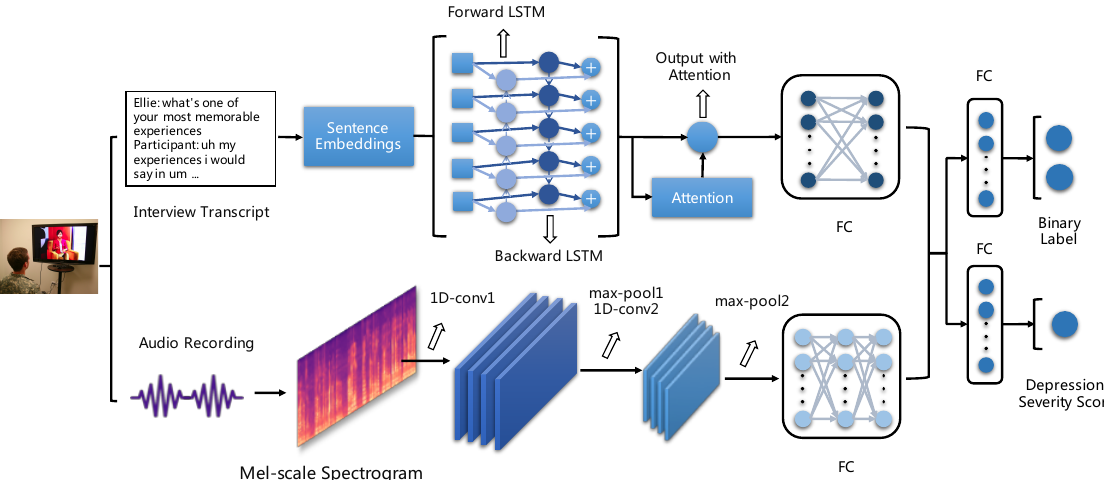
Figure 1. Framework of the proposed model. Text features are trained using a BiLSTM model with an attention layer, and audio features are trained with a 1D CNN model. Outputs from both BiLSTM and 1D CNN models are concatenated and fed into two fully connected networks (FC), one of which generates labels indicating whether the interviewees are depressed or not, and the other predicts depression severity scores,